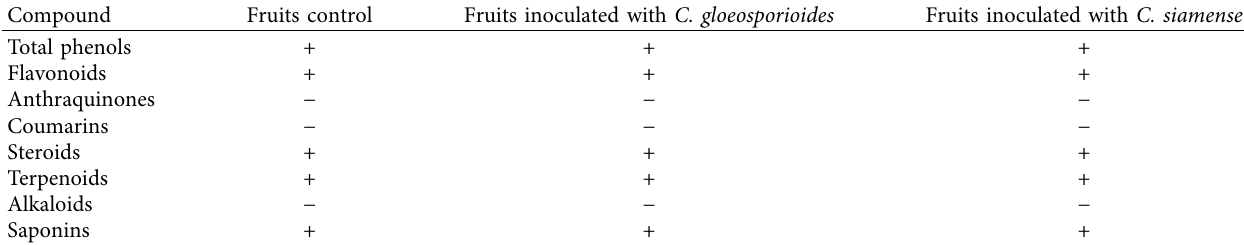
Table 1: Phytochemical compounds determined in the soursop fruit treatments. Compound Fruits control Fruits inoculated with C.